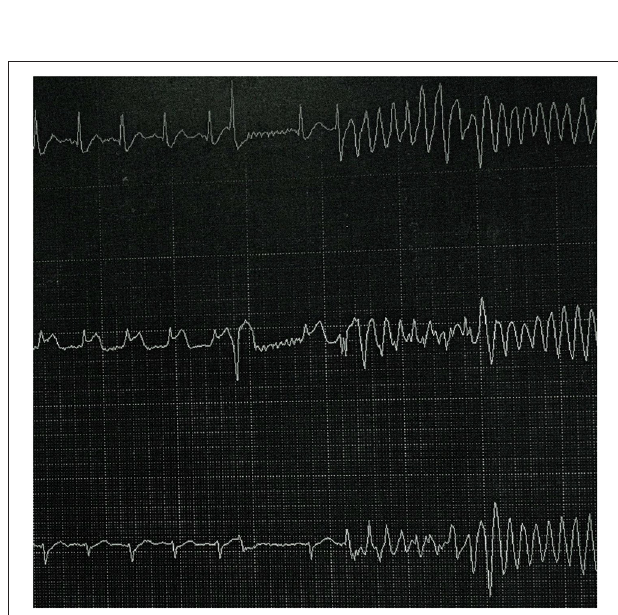
FIGURE 2 | ECG monitor data after cardiac arrest. ST-segment elevation induced TdP and VF after R-on-T